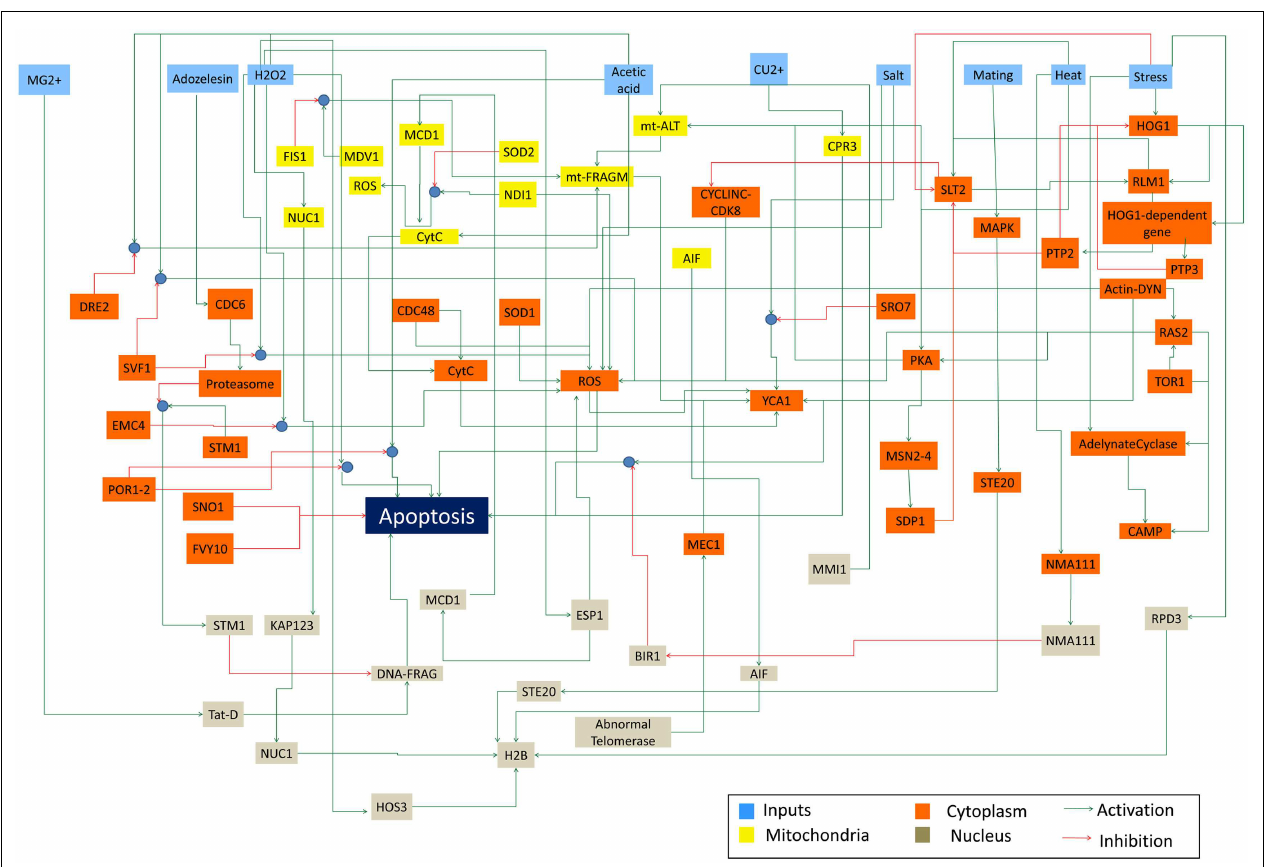
FIGURE 1 | Schematic representation ofYeastApoptosis network. Blue boxes depict input nodes, yellow nodes are placed in mitochondria, orange nodes reside in cytosol and grey nodes belong to nucleus. Green arrows show activation effect and red arrows show inhibition effect. Blue circles depict “AND”